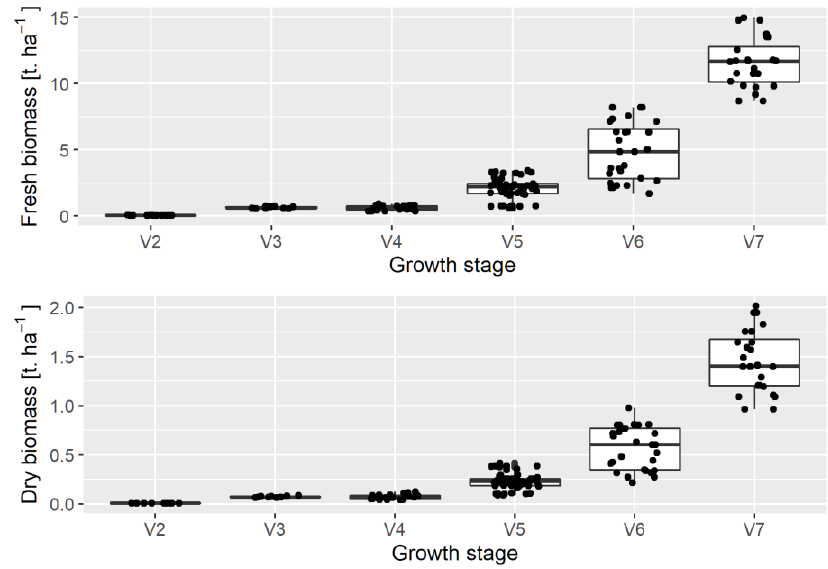
Figure 2. Boxplots of dry and fresh corn biomass values measured for each growth stage. Each point represents a ground reference with its biomass and V stage averaged among all sampled plants within that ground reference.